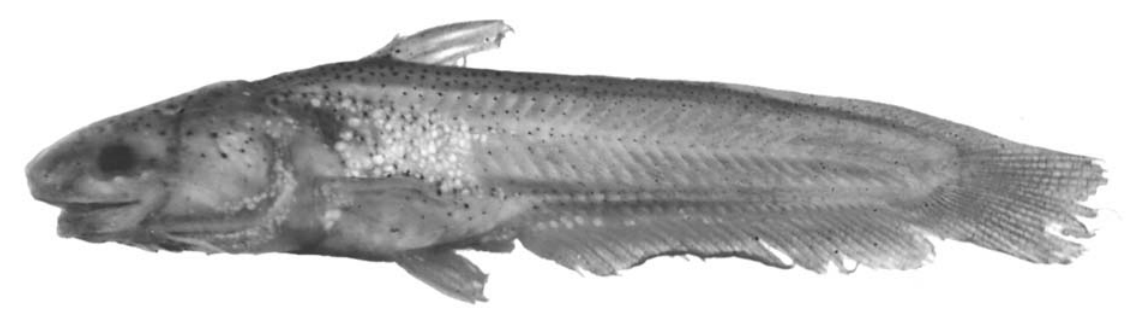
Fig. 52. Denticetopsis sauli , paratype, ANSP 161432, 16.5 mm SL; Venezuela, Amazonas, outflow stream from a series of morichales (palm swamps), approximately 5 km from mouth of río Pamoni, río Casiquiare basin (2°48’N,